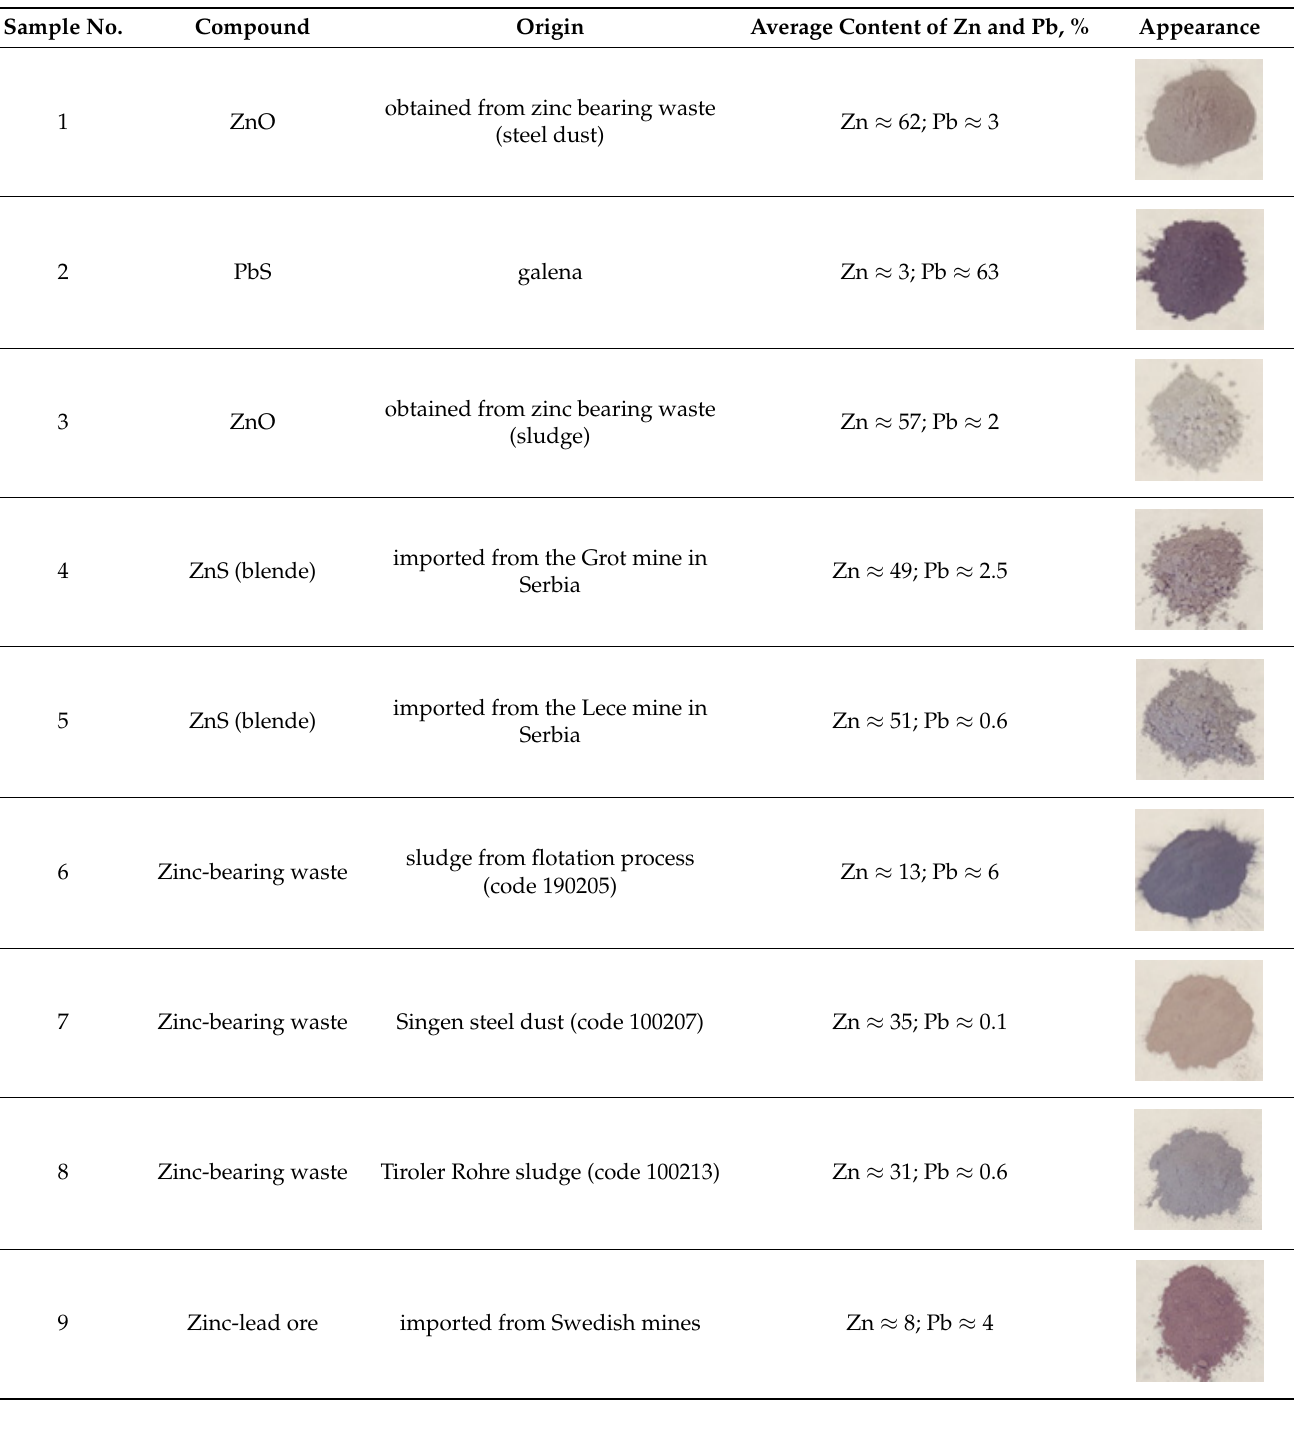
Table 6. List of tested samples.